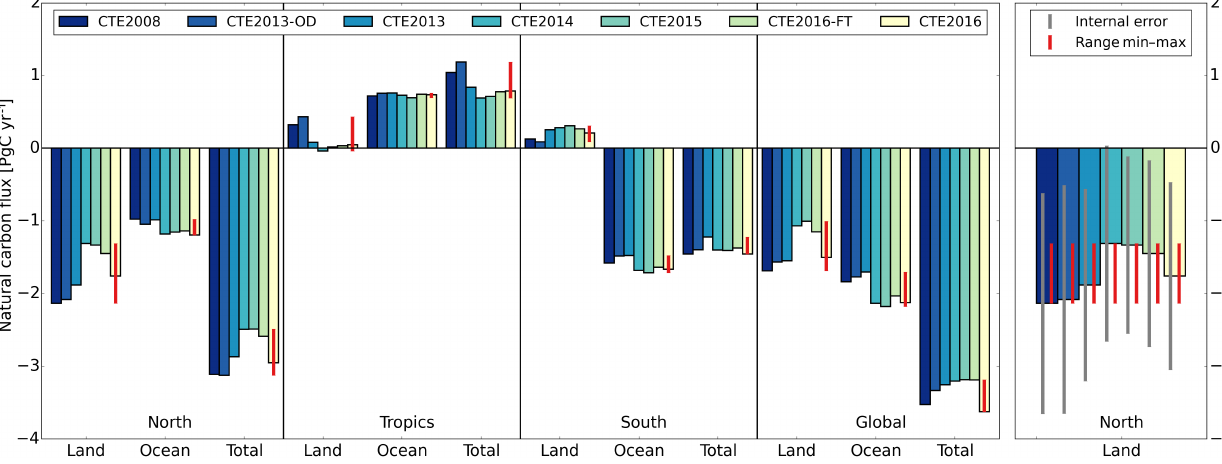
Figure 8. Average natural carbon flux estimates for different CTE versions for selected regions for the period 2001–2007 (left panel). The fluxes are the sum of the biosphere and ocean fluxes and biomass burning emissions. Two alternative uncertainty estimates are given for a selected region (right panel). The first is the internal error based on the average weekly posterior covariances ( n = 418), while the second is representing the range between the different realizations of the inversion ( n = 7). The second option is applied as the posterior uncertainty estimate per region in the left